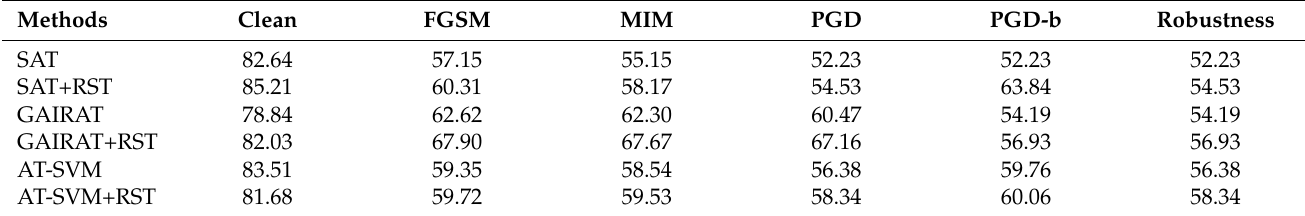
Table 5. Test accuracy of models training with/without RST.